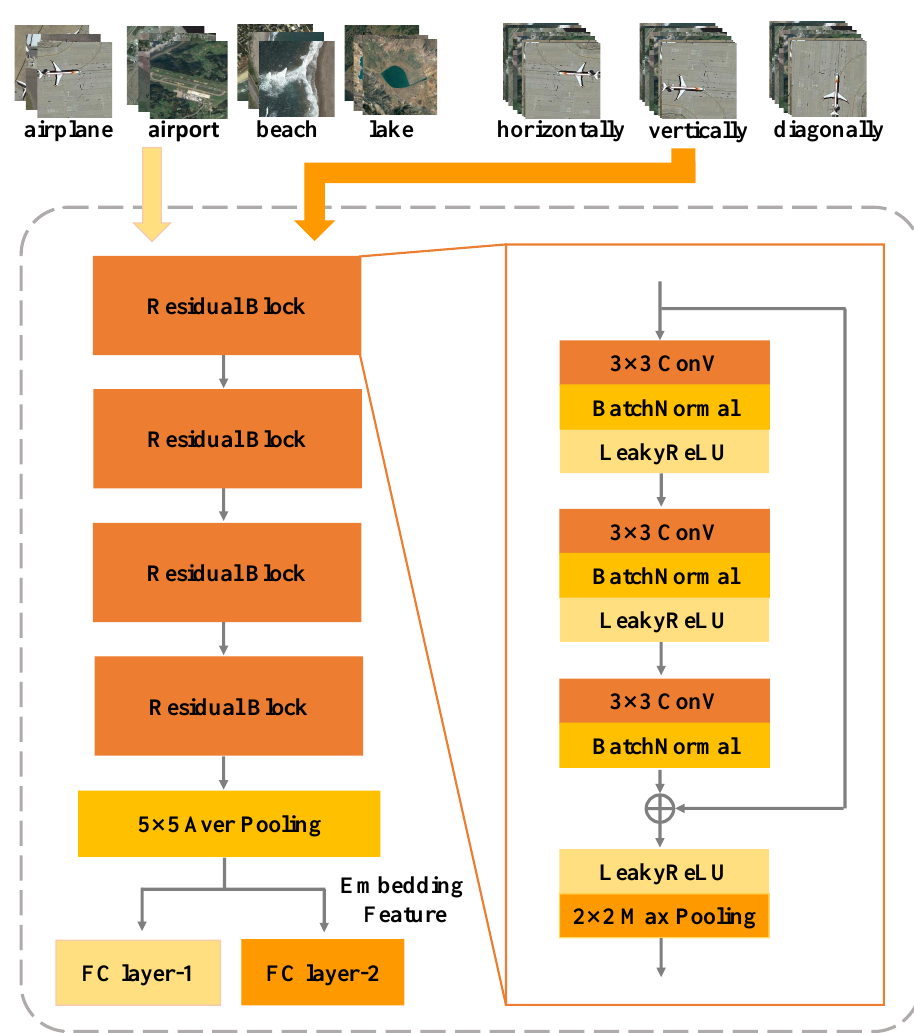
Figure 2. Schematic diagram of self-supervised auxiliary